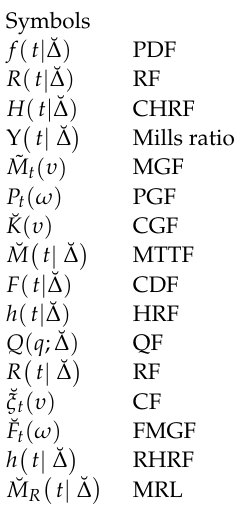
Fig. 19. The PLLF for Dataset II. Figure 19. The PLLF for Dataset